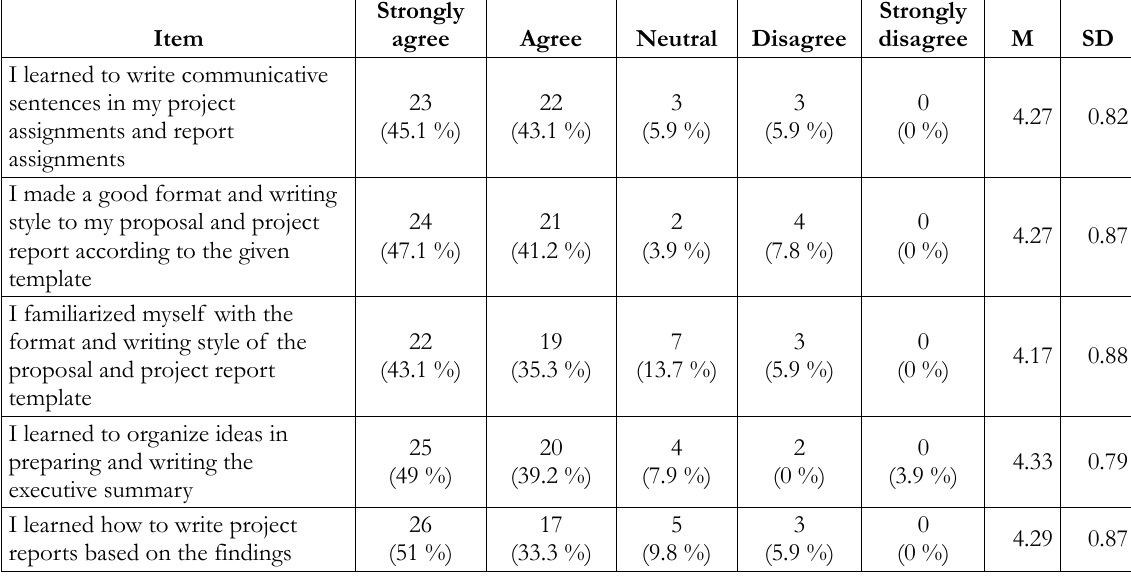
Table 6. The data analysis of students’ perceptions of communication skills